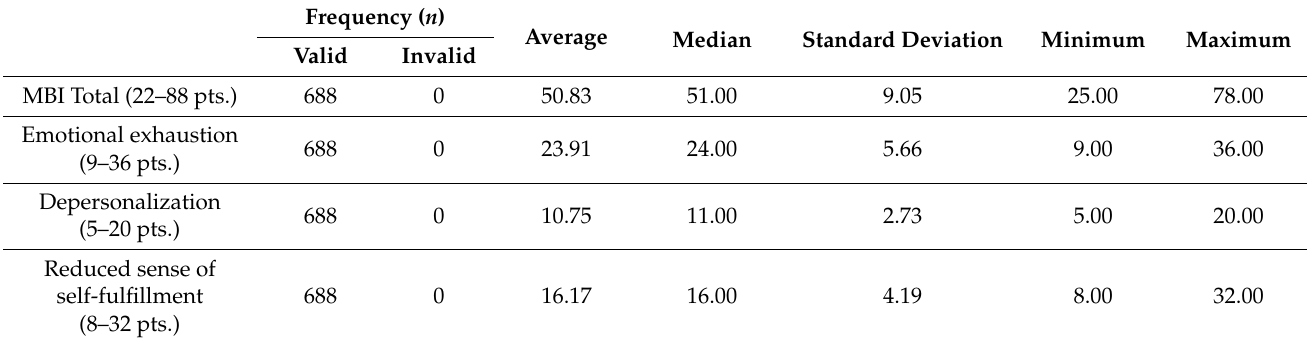
Table 2. Mean value of MBI occupational burnout of surveyed nurses.